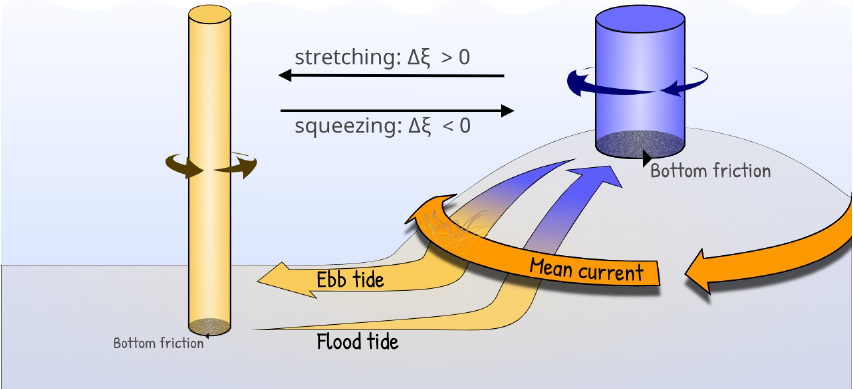
Figure 3. A sketch of mean-flow generation around a bank from oscillating flow across the bank topography. A water column oscillates up and down topography, attaining negative vorticity ξ on its way up the slope and positive vorticity on its way down due to vortex squeezing and stretching, respectively. Bottom friction removes some negative vorticity from the column over shallow regions and some positive vorticity over deep regions. A sustained oscillation, by a large-scale tidal potential, will be associated with a positive vorticity flux from shallow to deep water. The vorticity flux from many such columns is balanced by a mean anticyclonic circulation around the bank.